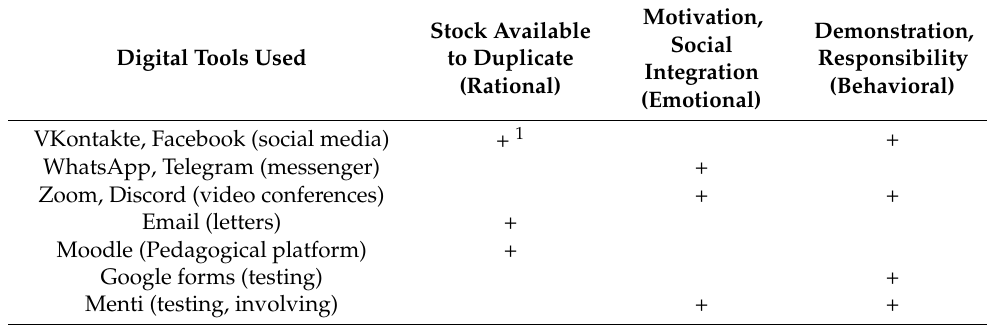
Table 4. Simplified grid of knowledge creation process through functional roles of